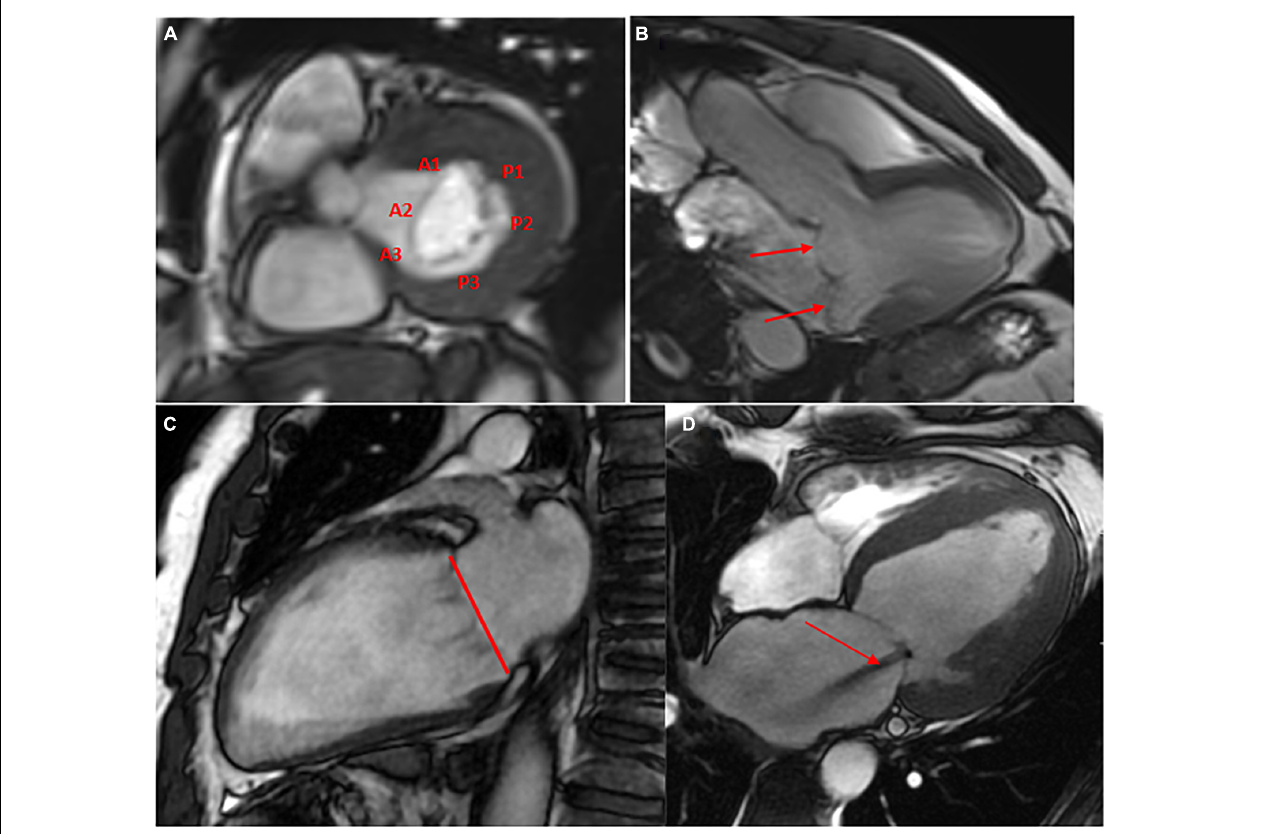
FIGURE 1 | Anterior and posterior mitral valves and their scallops (A1, A2 and A3 and P1, P2, P3) visualized in diastole using balanced steady-state free precession (bSSFP) cine images in the plane of the mitral valve (A) . Cine 4 chamber view in a patient with posterior and anterior mitral valve prolapse (red arrows) (B) . Example of mitral annular measurement from the anterior commissure to the posterior commissure (red line) in the 2-chamber view (C) . A central mitral regurgitation (flow void in the left atrium, red arrow) secondary to mitral annular dilatation visualized in the 4-chamber view (D) .